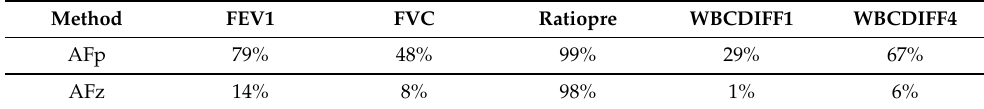
Table 3. The proportion of weight estimated to be 1 for significant genes (4367 and 3287 for AFp and AFz, respectively, determined by Bonferroni correction with cutoff 0.05) of AFp and AFz methods.